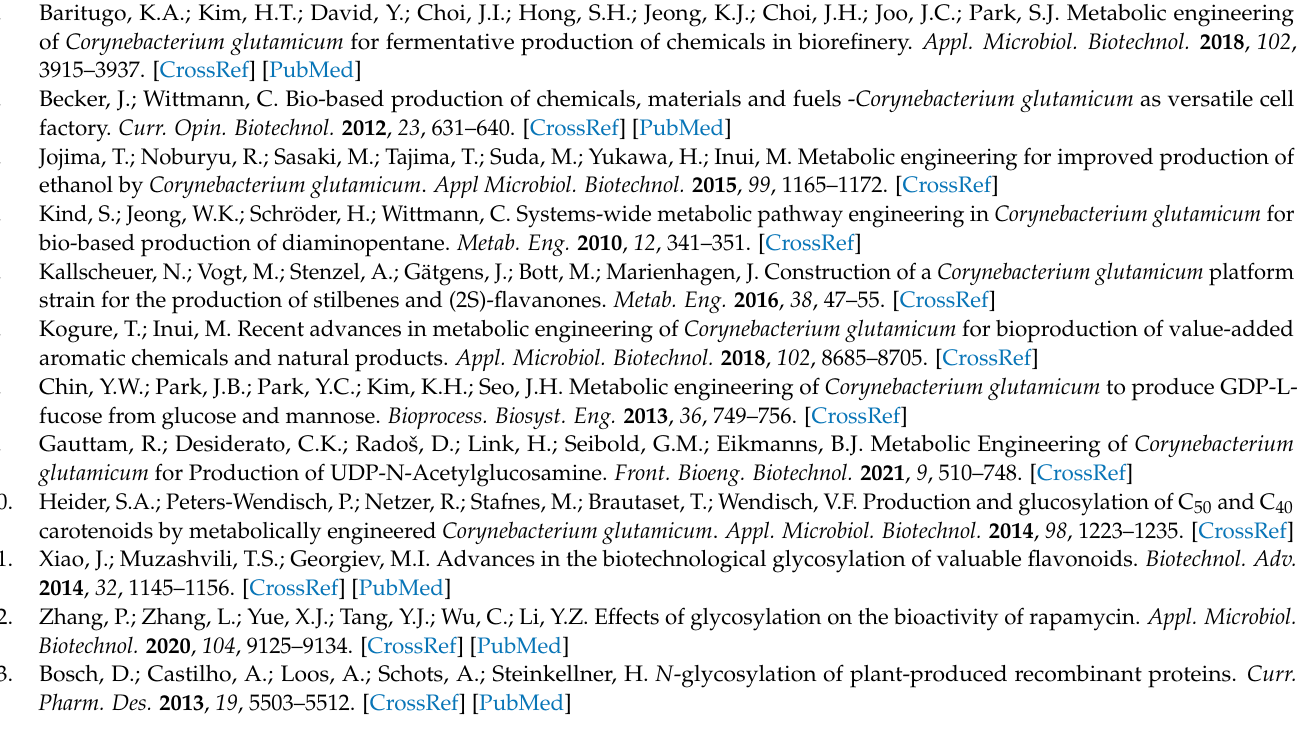
Figure S10. (A) 1 H NMR and (B) 13 C NMR of butyl-4-aminobenzoate-N- β -D-glucopyranoside,